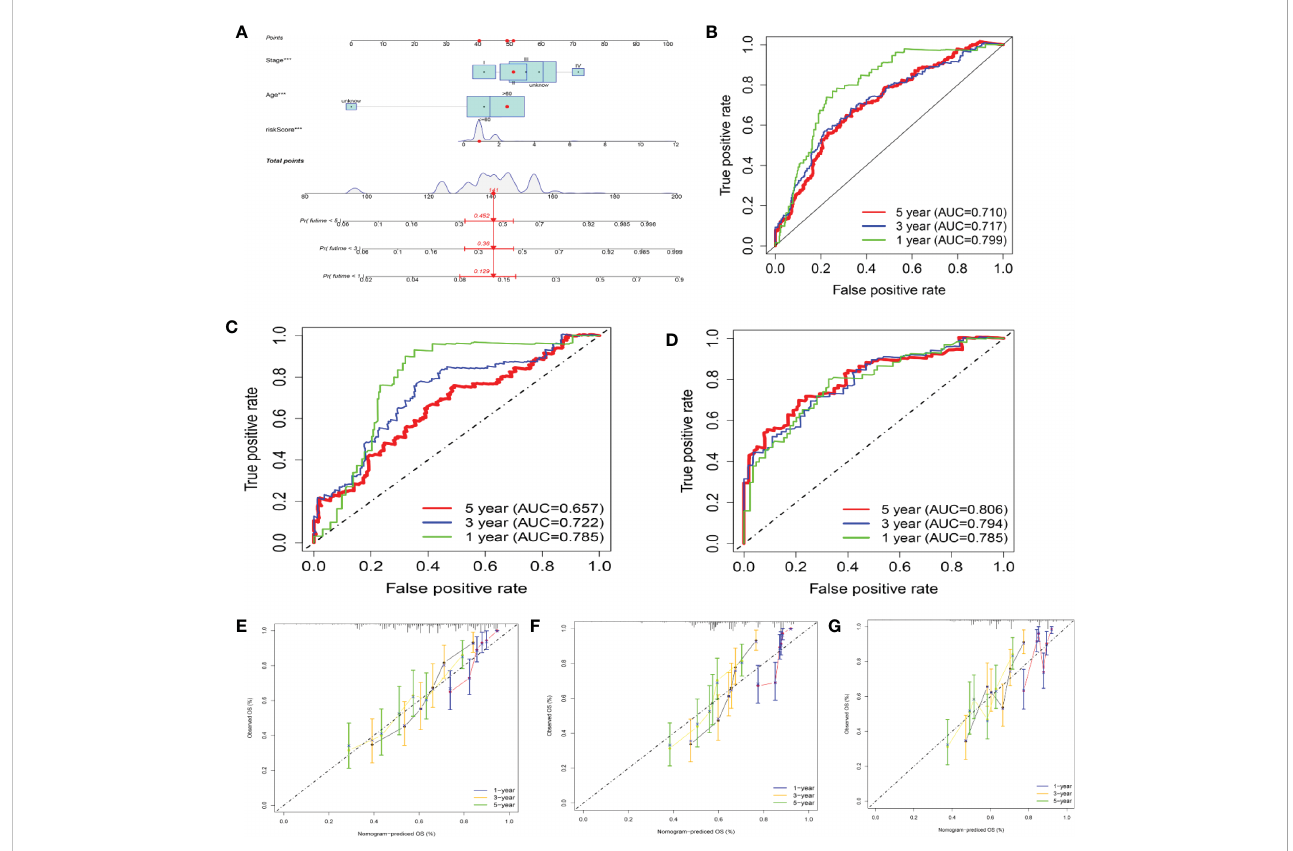
FIGURE 10 Building and validating a nomogram (A) Nomogram for forecasting melanoma patients ’ 1-, 3-, and 5-year survival in the training set. (B – D) ROC curves in the training, testing, and GSE65904 sets for forecasting the 1-, 3-, and 5-year ROC curves. (E – G) Nomogram calibration curves for forecasting 1-, 3-, and 5-year OS in the training, testing, and GSE65904